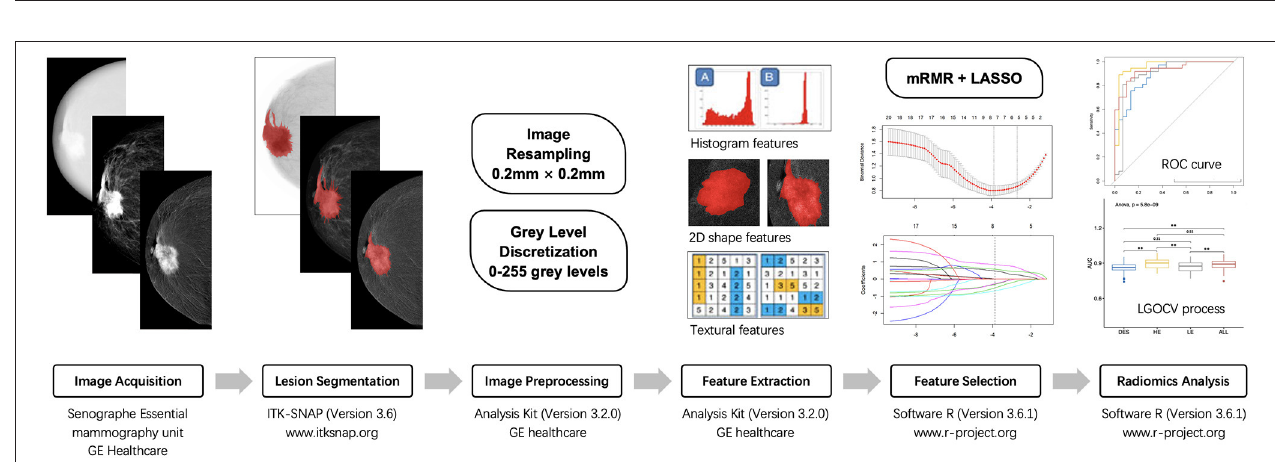
FIGURE 4 | The workflow of radiomic analysis in the study. mRMR, maximum relevance minimum redundancy; LASSO, least absolute shrinkage and selection operator; ROC, receiver operating characteristic; LGOCV, leave-group-out